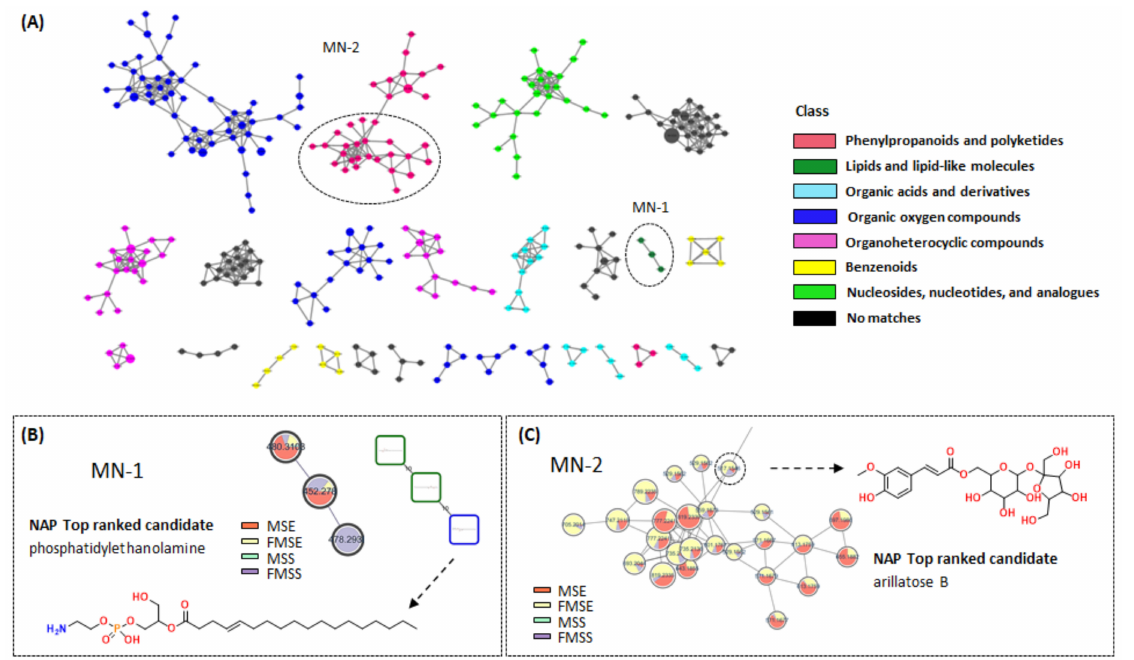
Figure 2. Molecular networking analysis of the various P. mume extracts. ( A ) Automatic classification and visualization of each cluster by MolNetEnhancer. ( B ) FBMN and NAP results of the MN-1 cluster. Numbers indicate the precursor ion m/z , spectral size indicates the total sum of precursor ion intensity in MS1 scans, and each node is colored according to the different extracts of P. mume . The node of m/z 478.2938 was predicted by NAP. Node borders in NAP are either green (spectral library match) or blue (in silico prediction). ( C ) FBMN result of MN-2 cluster and NAP top ranked candidate for the node of m/z 517.1546.